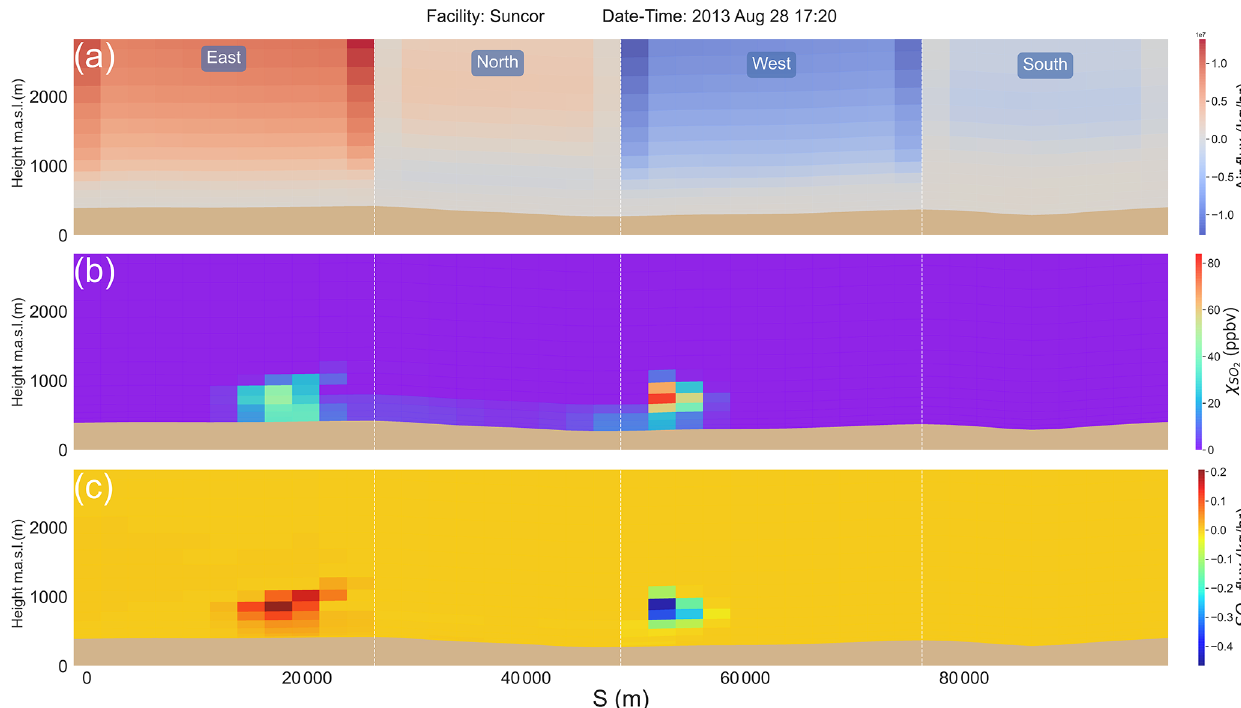
Figure 11. Case 8 screens around Suncor: (a) air flux screen, (b) SO 2 mixing ratio screen and (c) SO 2 mass flux screen. Note the strong negative flux (inflow) on the western wall and the weaker positive flux (outflow) on the eastern wall resulting in (temporal avg.) φ = 13%.